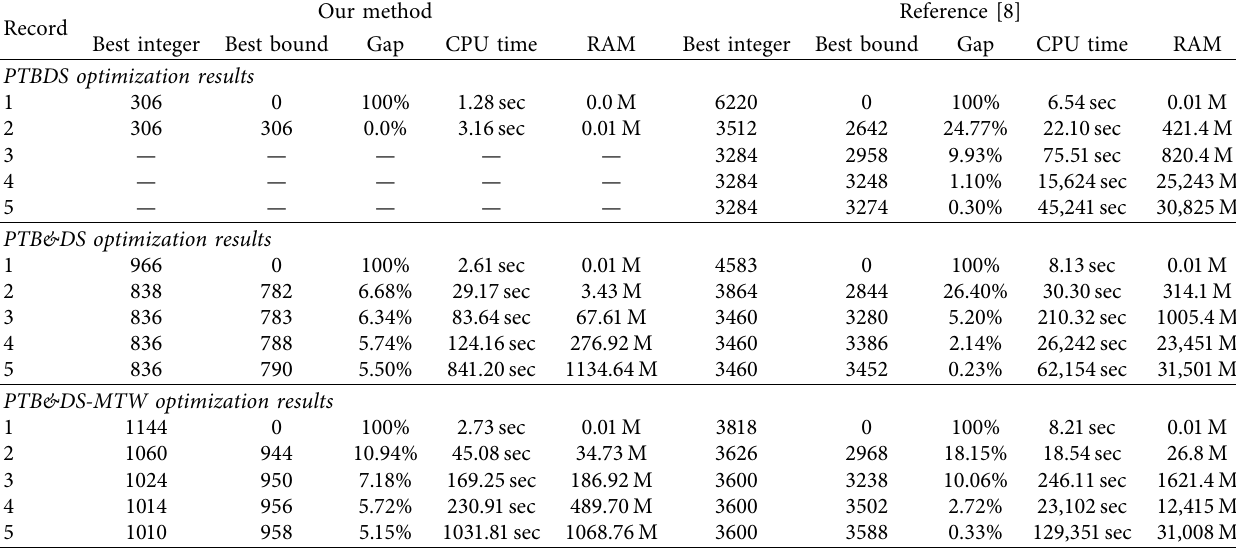
Table 4: Comparison of computational efficiency in solving the same case study.